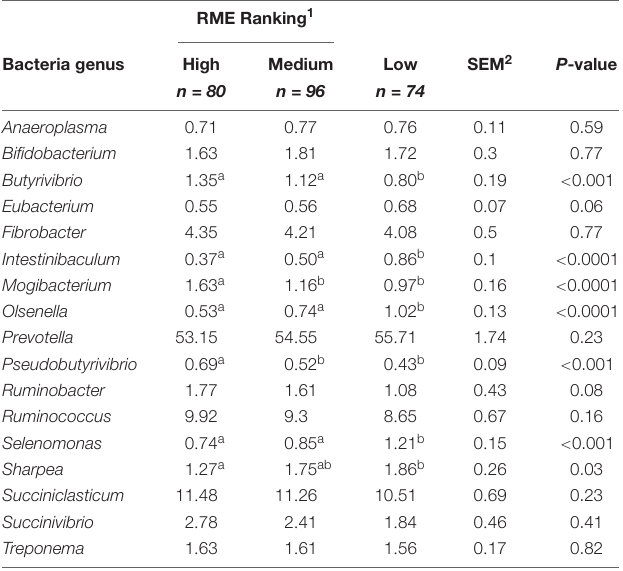
TABLE 1 | Characterization of the rumen bacterial genera in finishing beef cattle ranked for residual methane.